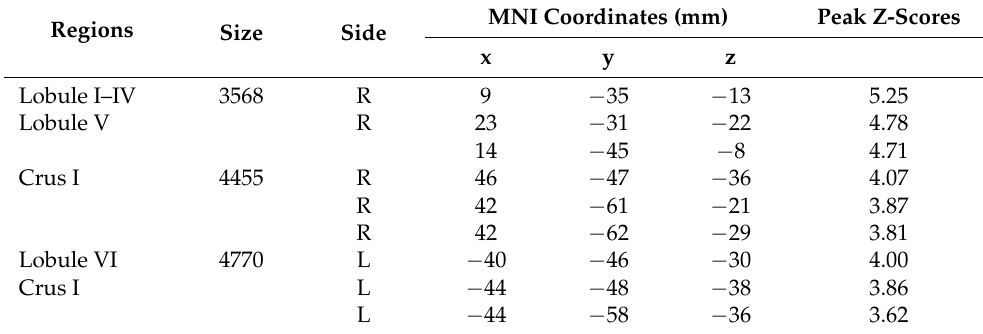
Figure 2. Between-group voxel-based comparison of cerebellar GM density. Cerebellar regions showing patterns of significantly reduced GM in bvFTD are reported and superimposed on the Spatially Unbiased Infratentorial Template (SUIT) [49] in coronal (y), sagittal (x), and axial (z) slices. The results are significant at p -values < 0.05 after I cluster-level correction. Images are shown in neurological convention. R: right, L: left. Table 2. Detailed statistics of voxel wise comparisons of cerebellar GM density (bvFTD <